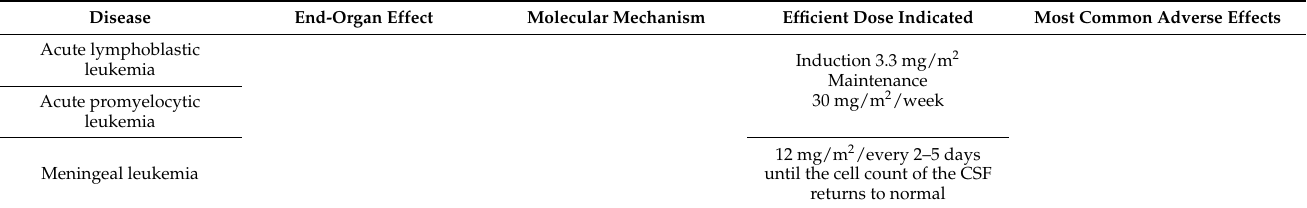
Table 1. Synopsis of MTX as disease-modifying agent in multiple disease